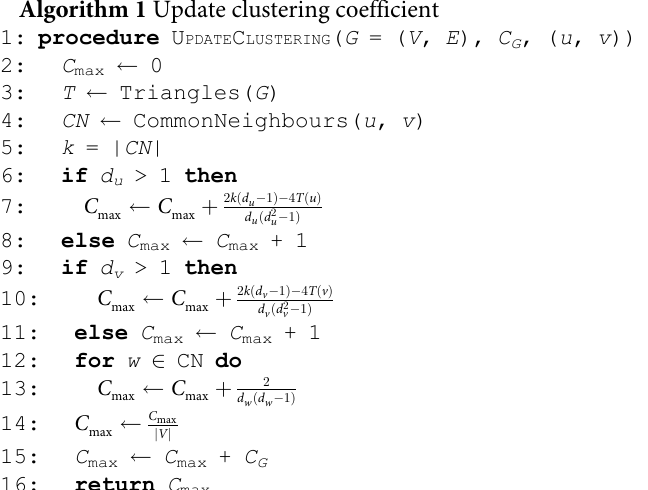
Algorithm 1 Update clustering coefficient